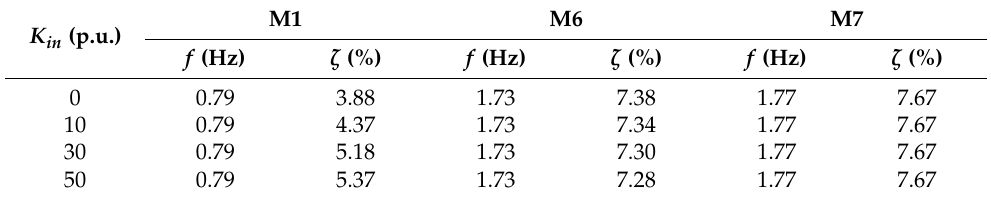
Table 15. Effect of increasing SI contribution from FCWTs on the modes in the Low Load DP. K in (p.u.)